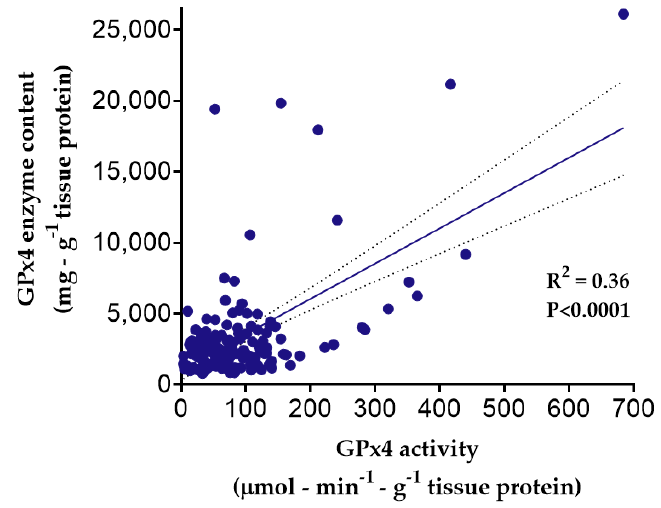
Figure 2. Relationship between GPx4 enzyme content and activity in human atrial myocardium. GPx4 enzyme activity (μmol · min −1 · g −1 total protein) and total GPx4 enzyme (mg) were measured in fresh lysates prepared from samples of human atrial myocardium using protocols described in Methods section. Both enzyme activity and enzyme concentration values shown here are normalized against the total tissue protein (g). Each symbol corresponds to one individual patient (N = 189 patients). Statistical significance was calculated using simple linear regression, with dashed lines showing 95% confidence intervals.